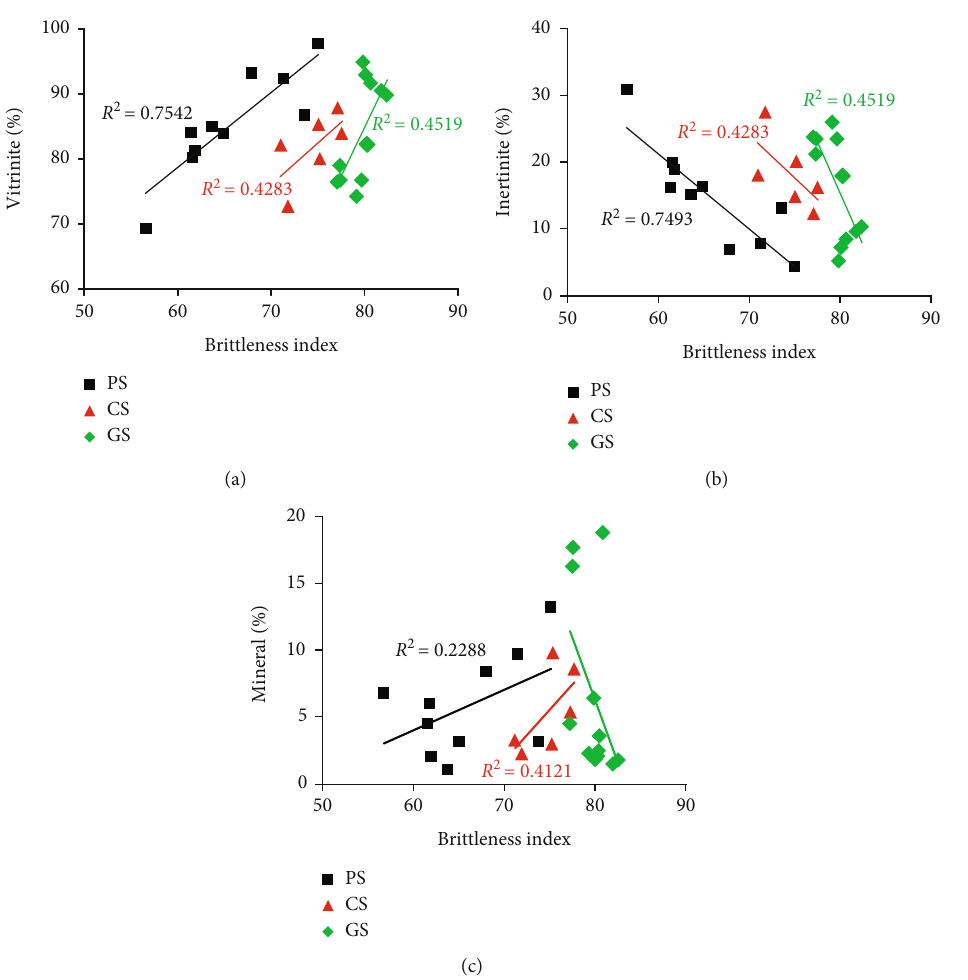
Figure 4: Relationship between microscopic composition, brittleness index, and Young ’ s modulus. PS is primary structure, CS is cataclastic structure, and GS is granulate